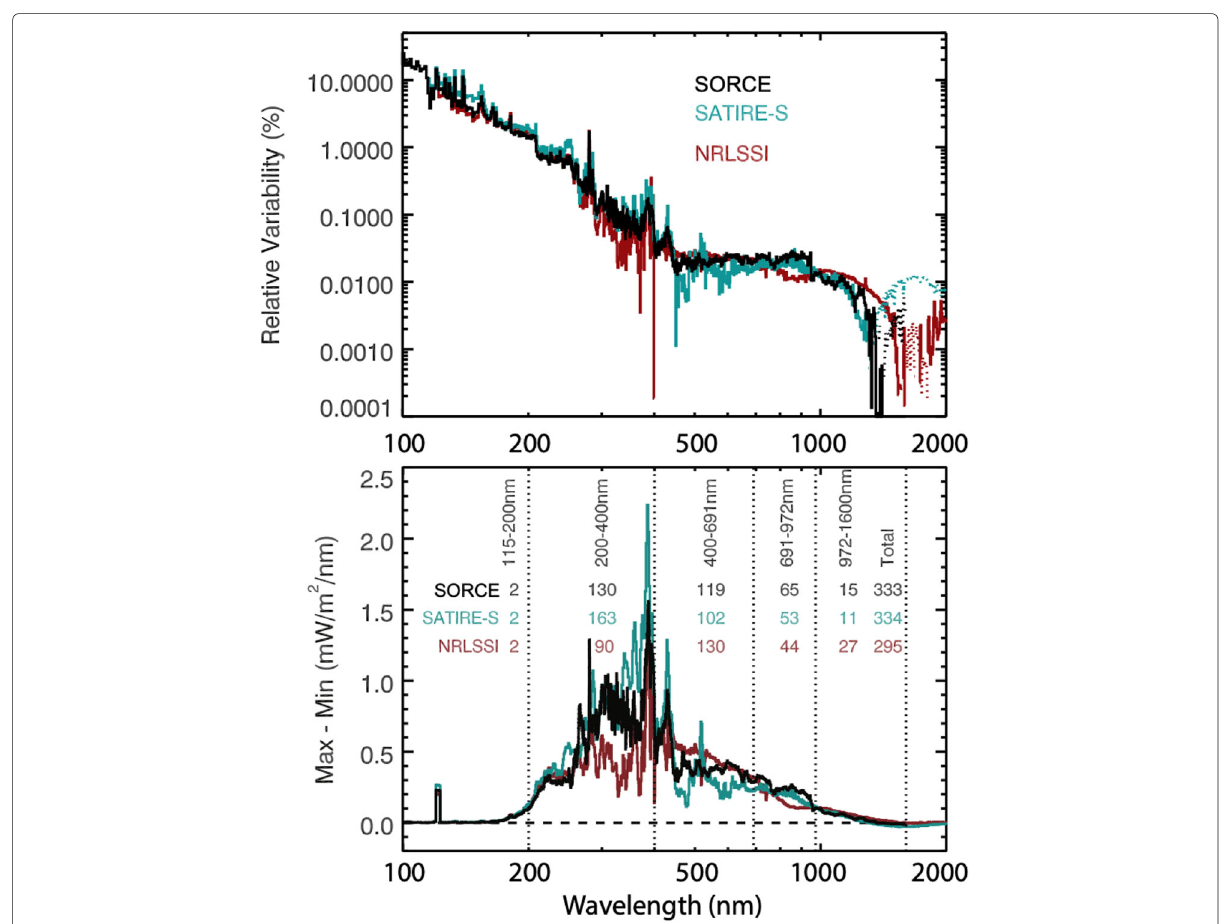
Fig. 7 SORCE solar spectral irradiance variability. The SORCE solar spectral irradiance variability results from Woods et al. (2015), shown in black, are compared to the SATIRE-S (blue) and NRLSSI (red) model estimates for solar variability between February 2002 (max) to December 2008 (min). The top panel shows the relative variability in percent, and the bottom panel shows the absolute variability in irradiance units. The dashed lines are out-of-phase (negative) solar cycle variability results. The irradiance variability (max-min) in broadbands is provided, and those numbers are in units of mW/m 2 . The total variability is for the 115 to 1600 nm range. This figure is adapted from Woods et al.